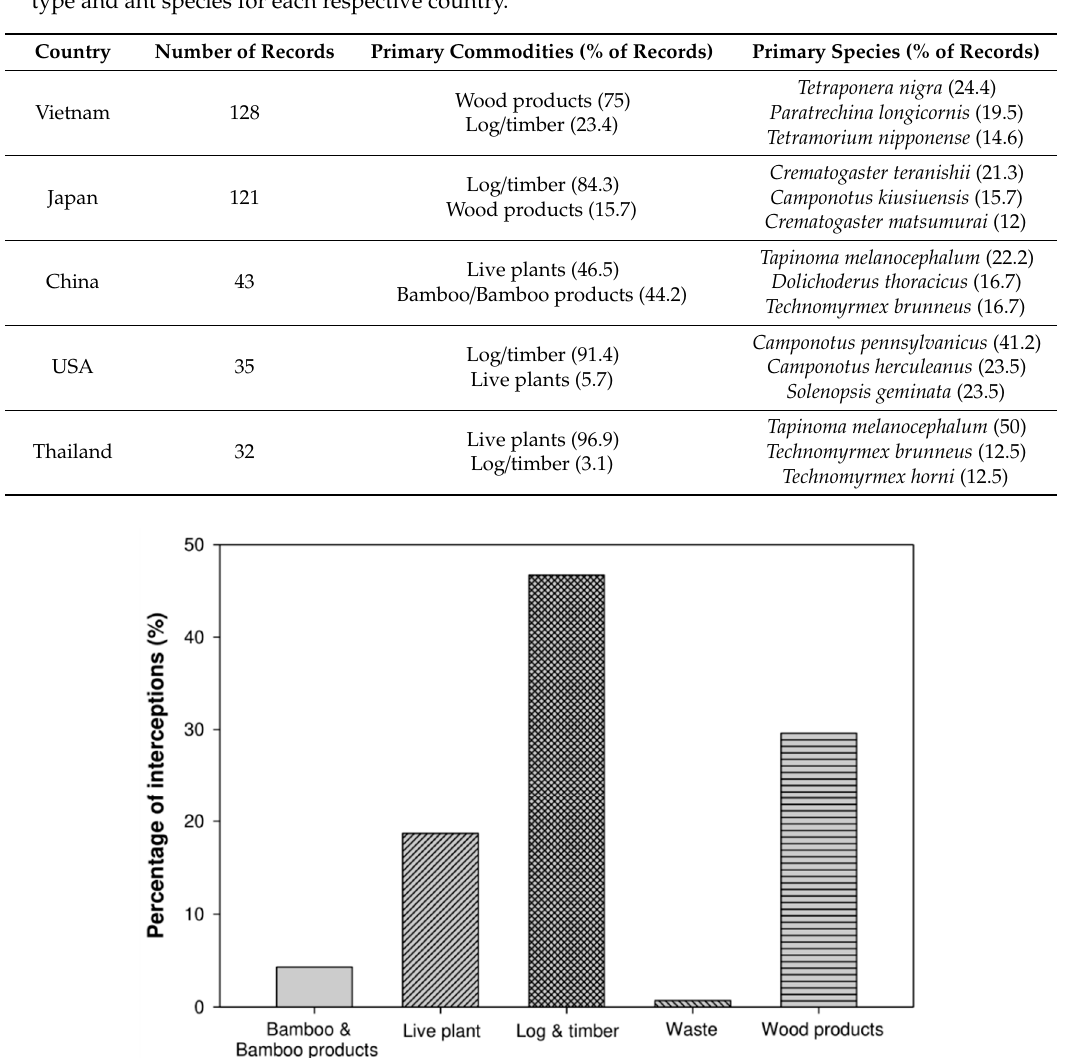
Table 2. Top five countries of origin ranked by number of ant interceptions, and the primary commodity type and ant species for each respective country.